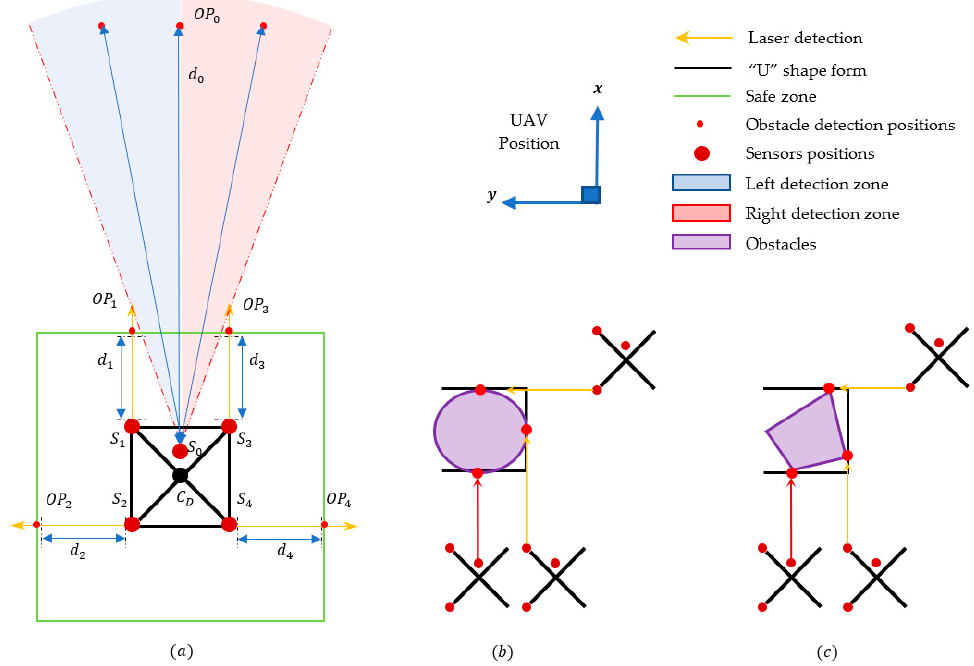
Figure 7. Obstacle positions in the perspective of different sensors. ( a ) Obstacle’s positions in perspective of UAV, UAV’s position rectangular; ( b ) shape formation for circular object; ( c ) shape formation for trapezium object.